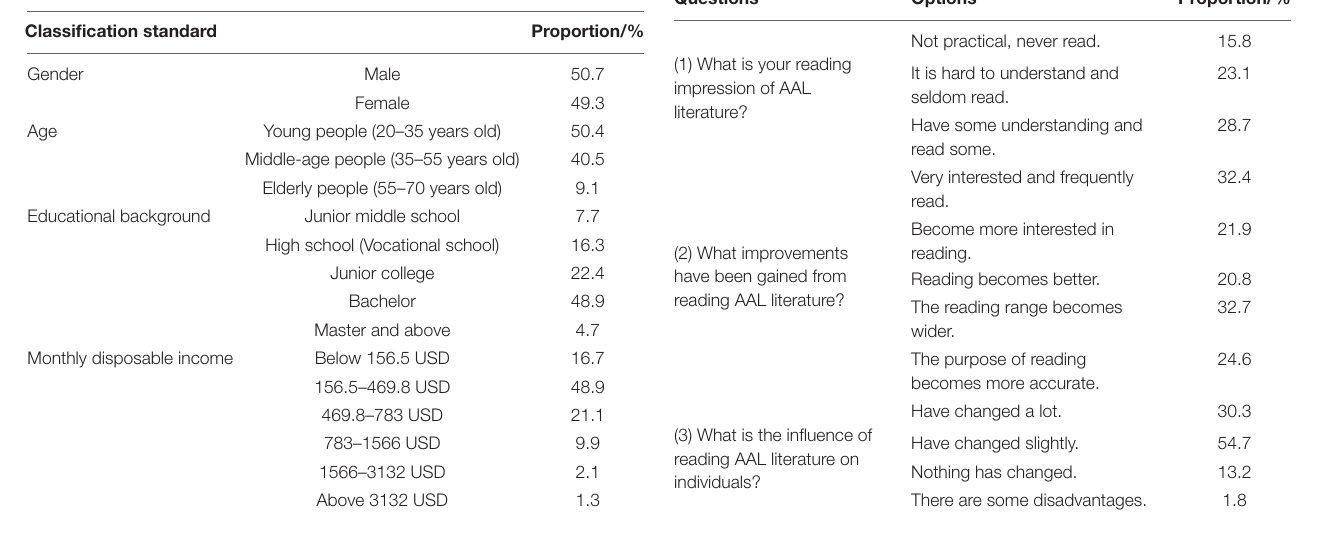
TABLE 3 | Basic information of respondents.